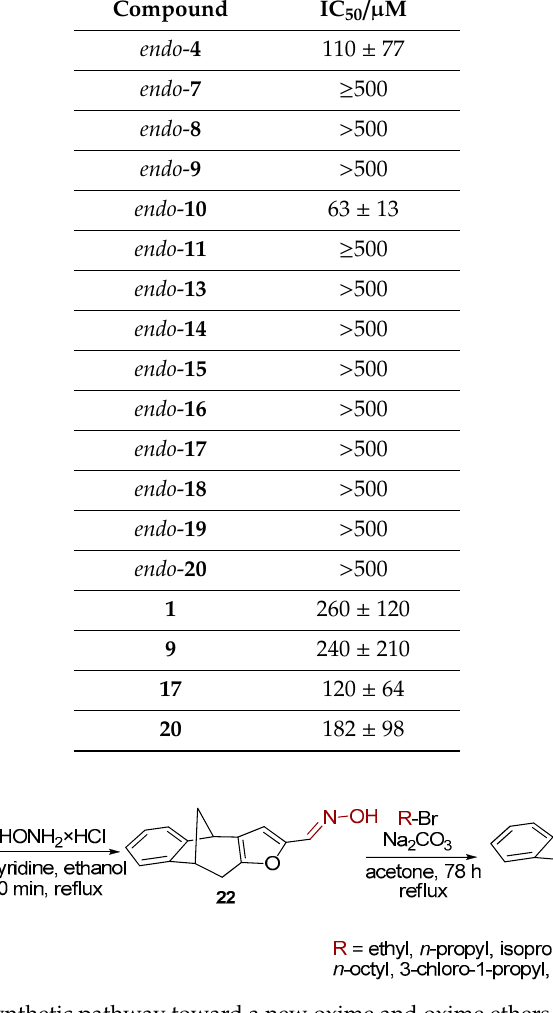
Table 1. Inhibition of BChE by benzobicyclo[3.2.1]octadiene benzylamines expressed as IC 50 ±